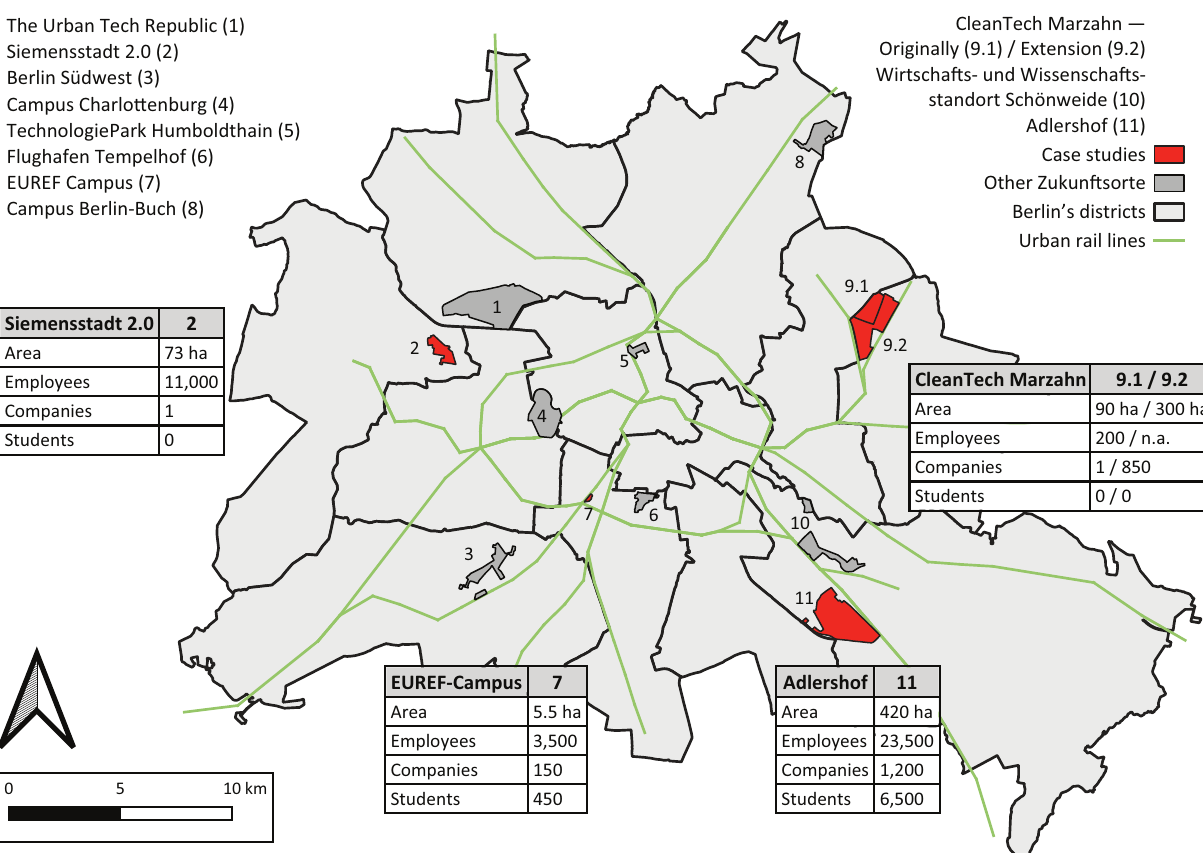
Figure 2. Berlin’s